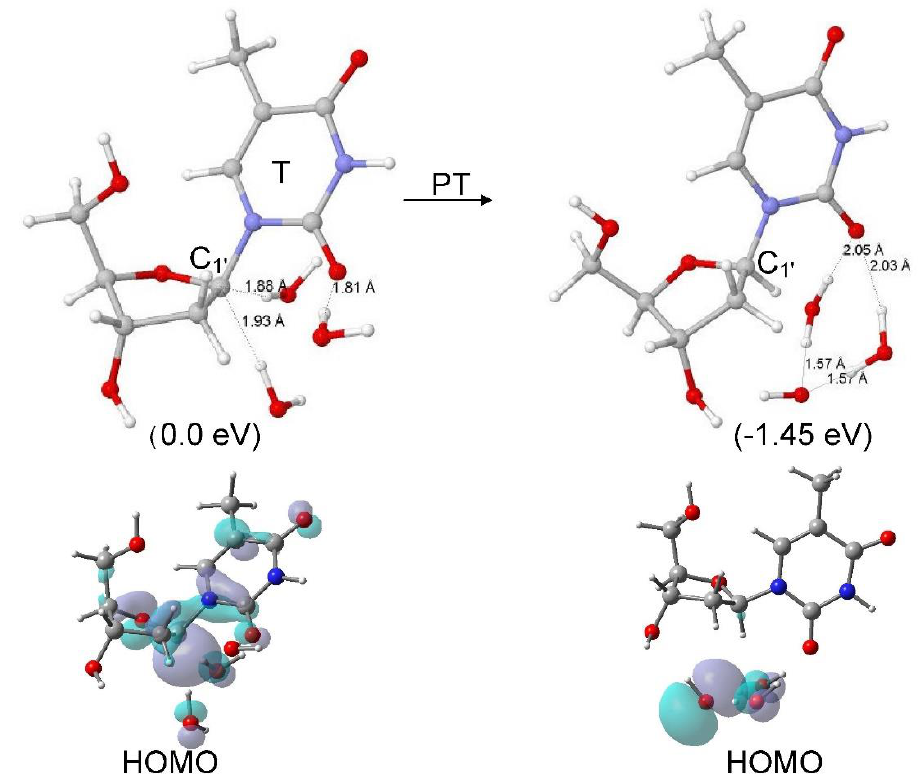
Figure 3. ωB97XD-PCM/6-31++G**-calculated optimized structure of 2′-dT(C1′ − ) + 3H 2 O, before Figure 3. ω B97XD-PCM/6-31++G**-calculated optimized structure of 2 (cid:48) -dT(C1 (cid:48)− ) + 3H 2 O, before and after proton transfer and after proton transfer from a water molecule to C1′ of 2′-dT. The HOMO in 2′-dT(C1′ − ) + 3H 2 O from a water molecule to C1 (cid:48) of 2 (cid:48) -dT. The HOMO in 2 (cid:48) -dT(C1 (cid:48)− ) + 3H 2 O (before PT) is localized mainly at C1 (cid:48) atom of the (before PT) is localized mainly at C1′ atom of the sugar ring and on PT to C1′ localized on the OH − . sugar ring and on PT to C1 (cid:48) localized on the OH − . The proton transferred structure is 1.45 eV more stable than before PT The proton transferred structure is 1.45 eV more stable than before PT structure. PT = proton trans- structure. PT = proton fer.